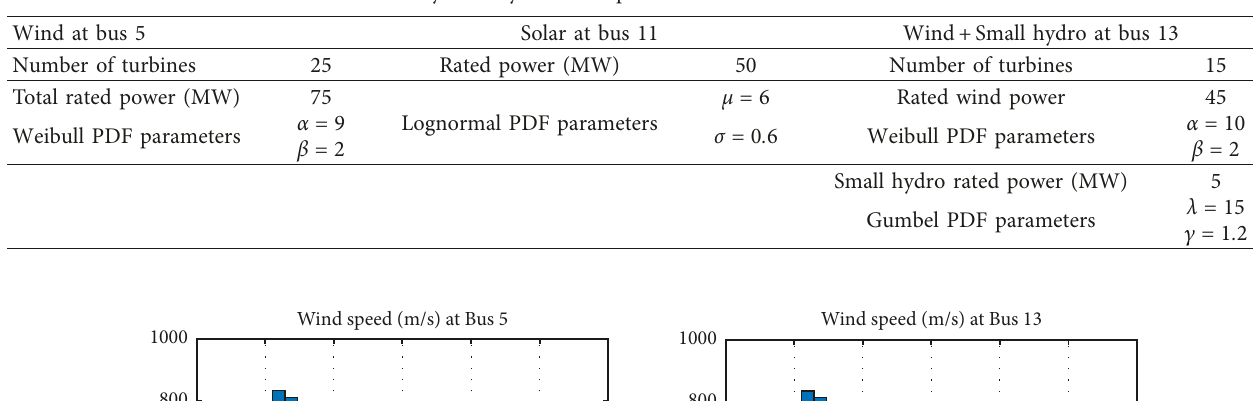
Table 3: Probability Density Function parameters for the RES stochastic models.